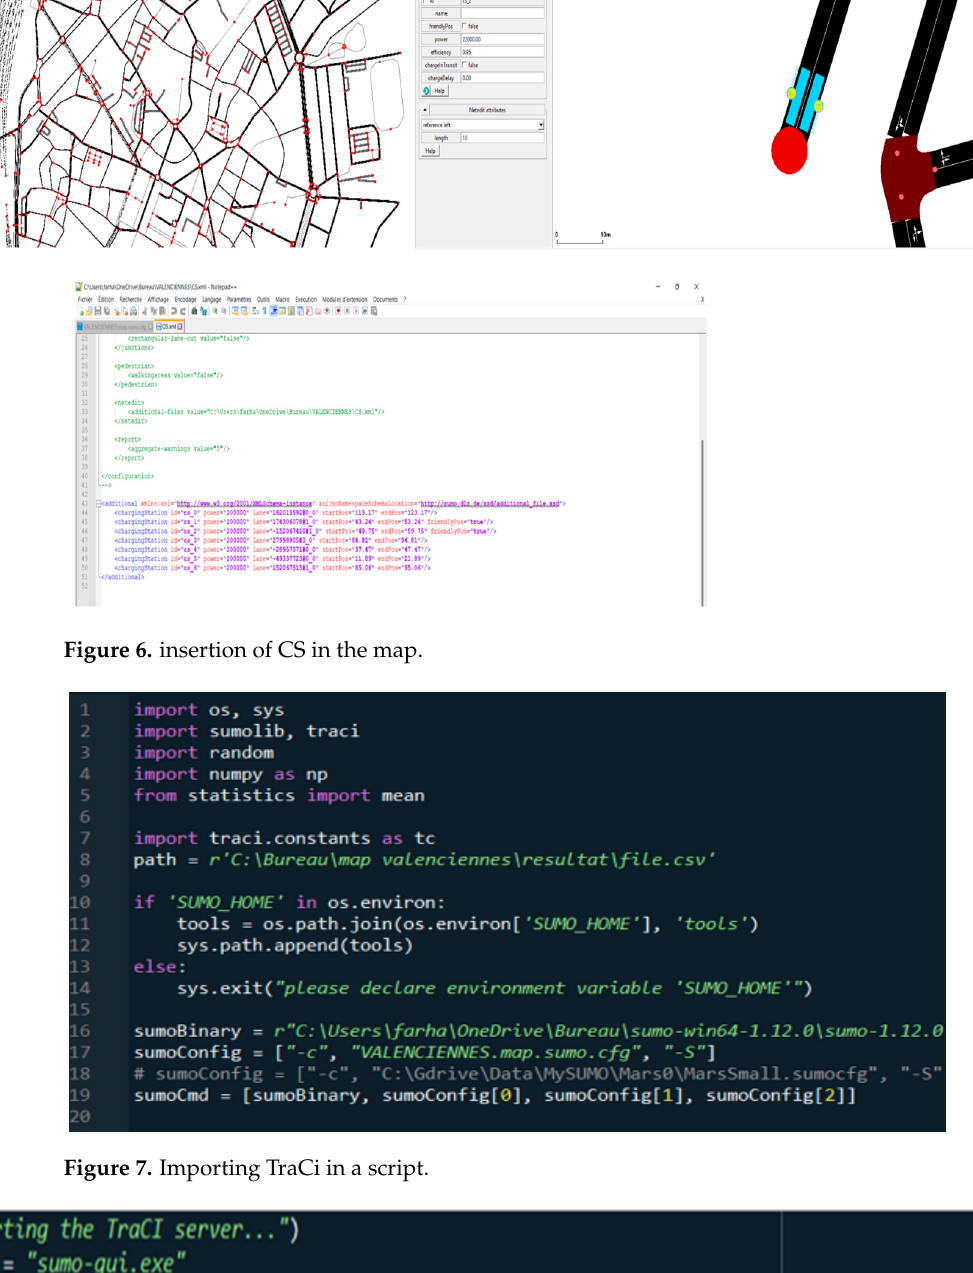
Figure 6. insertion of CS in the map.